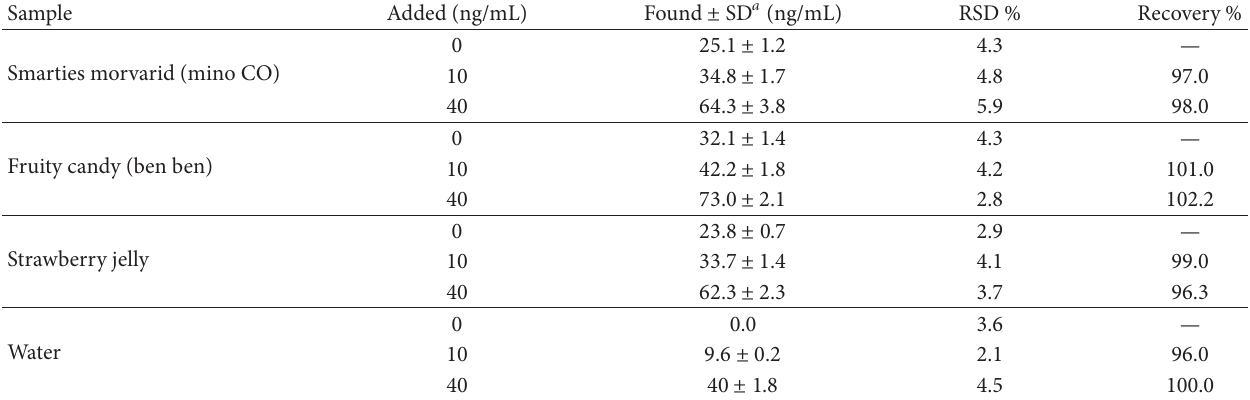
T 2: Determination of brilliant blue FCF in water and food samples by the proposed aqueous two-phase system (